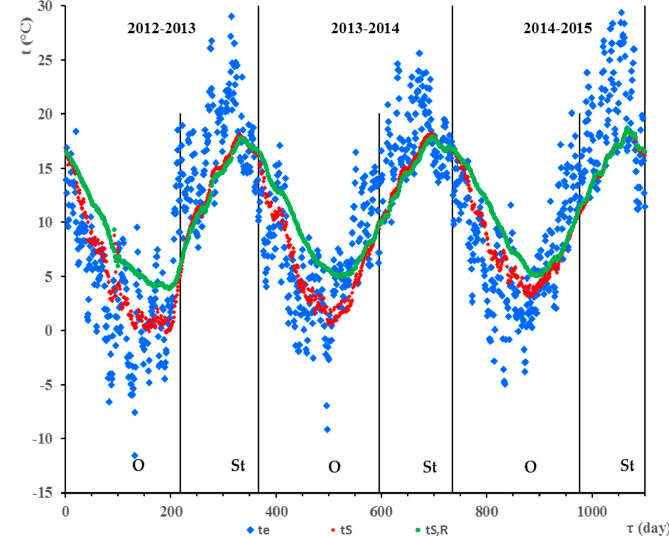
Figure 2. Ground mass temperatures in the area of the slinky HGHE ( t S ), reference ground mass ( t SR ), and ambient air temperatures ( t e ). O—operation of HGHE; St—stagnation of HGHE. During the heating periods, both HGHEs showed almost identical decrease in average daily ground mass temperature. During each heating period, temperature decreased on average by Δ t O , L = 7.76 K, for the linear HGHE and by Δ t O , S = 7.98 K, for the slinky HGHE. The decrease in the average daily temperature of the mass was affected by the ambient temperature and the duration of the